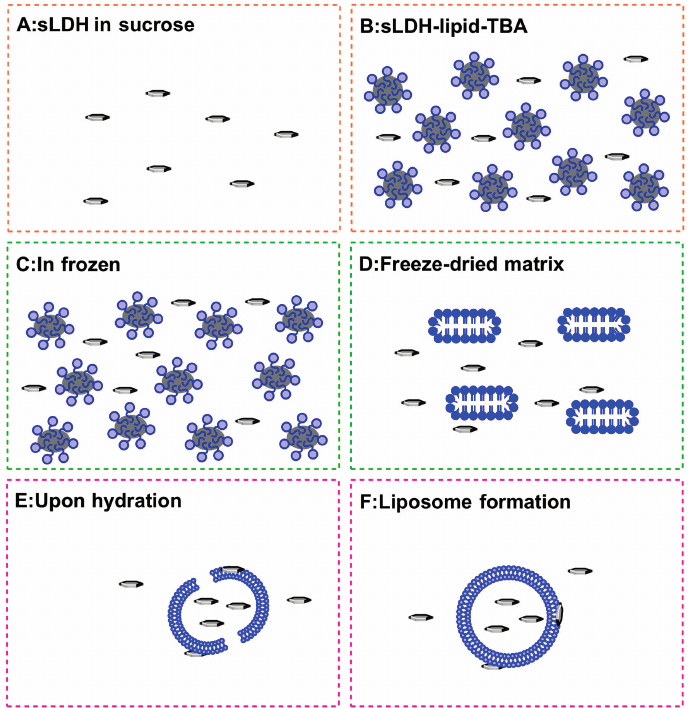
Figure 2. Schematic of the proposed sLDH–liposome composite formation by the HFDM method (for clarity, sucrose is not